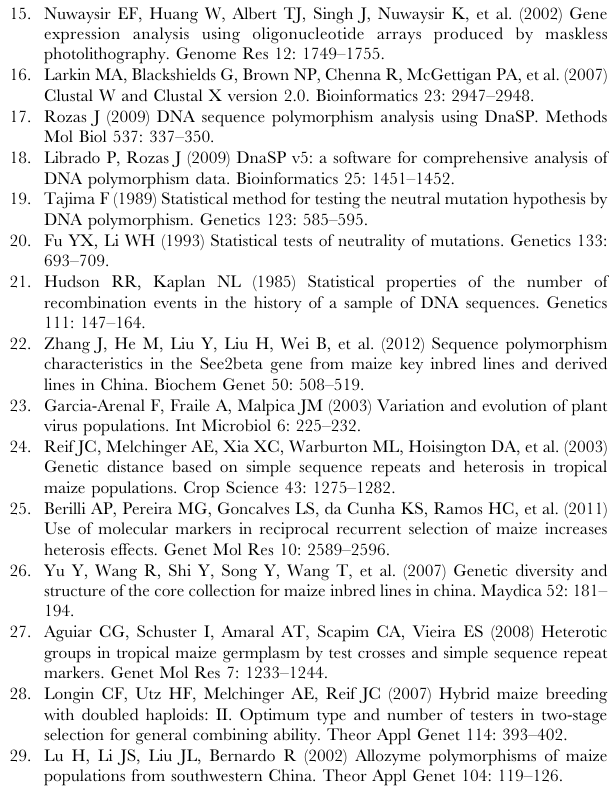
Table S1 The positions of nucleotide polymorphism of RTCS gene among 73 inbred lines. Table S2 The distribution of haplotypes of RTCS gene in 73 inbred lines using the entire sequences. Table S3 The distribution of haplotypes of RTCS gene in 73 inbred lines using the coding